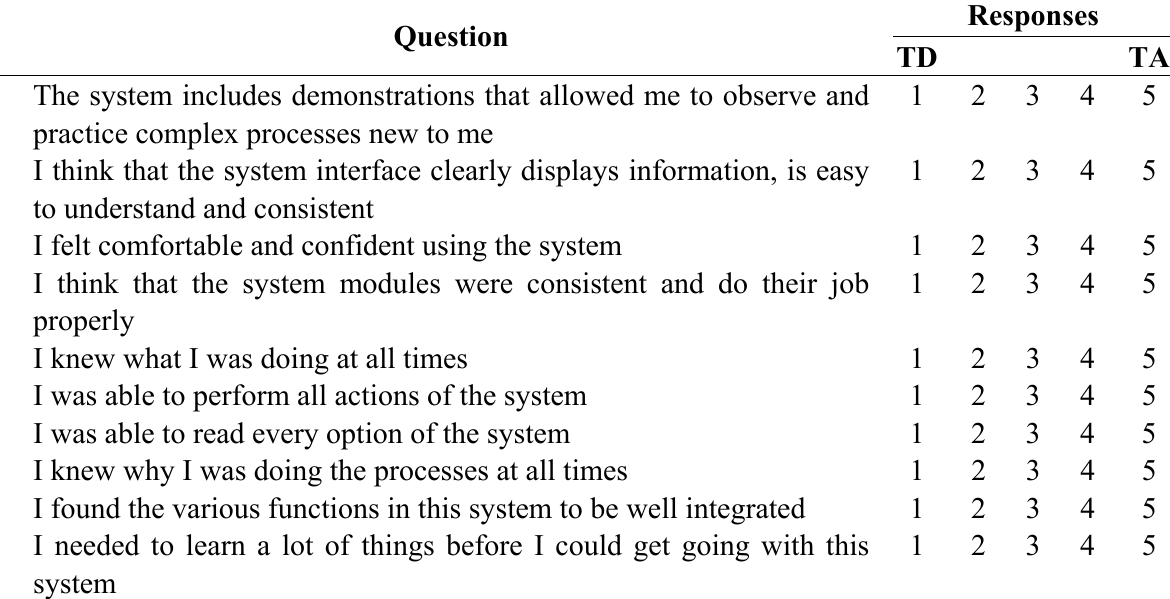
Table 4. Questionnaire no. 2: Usability of the